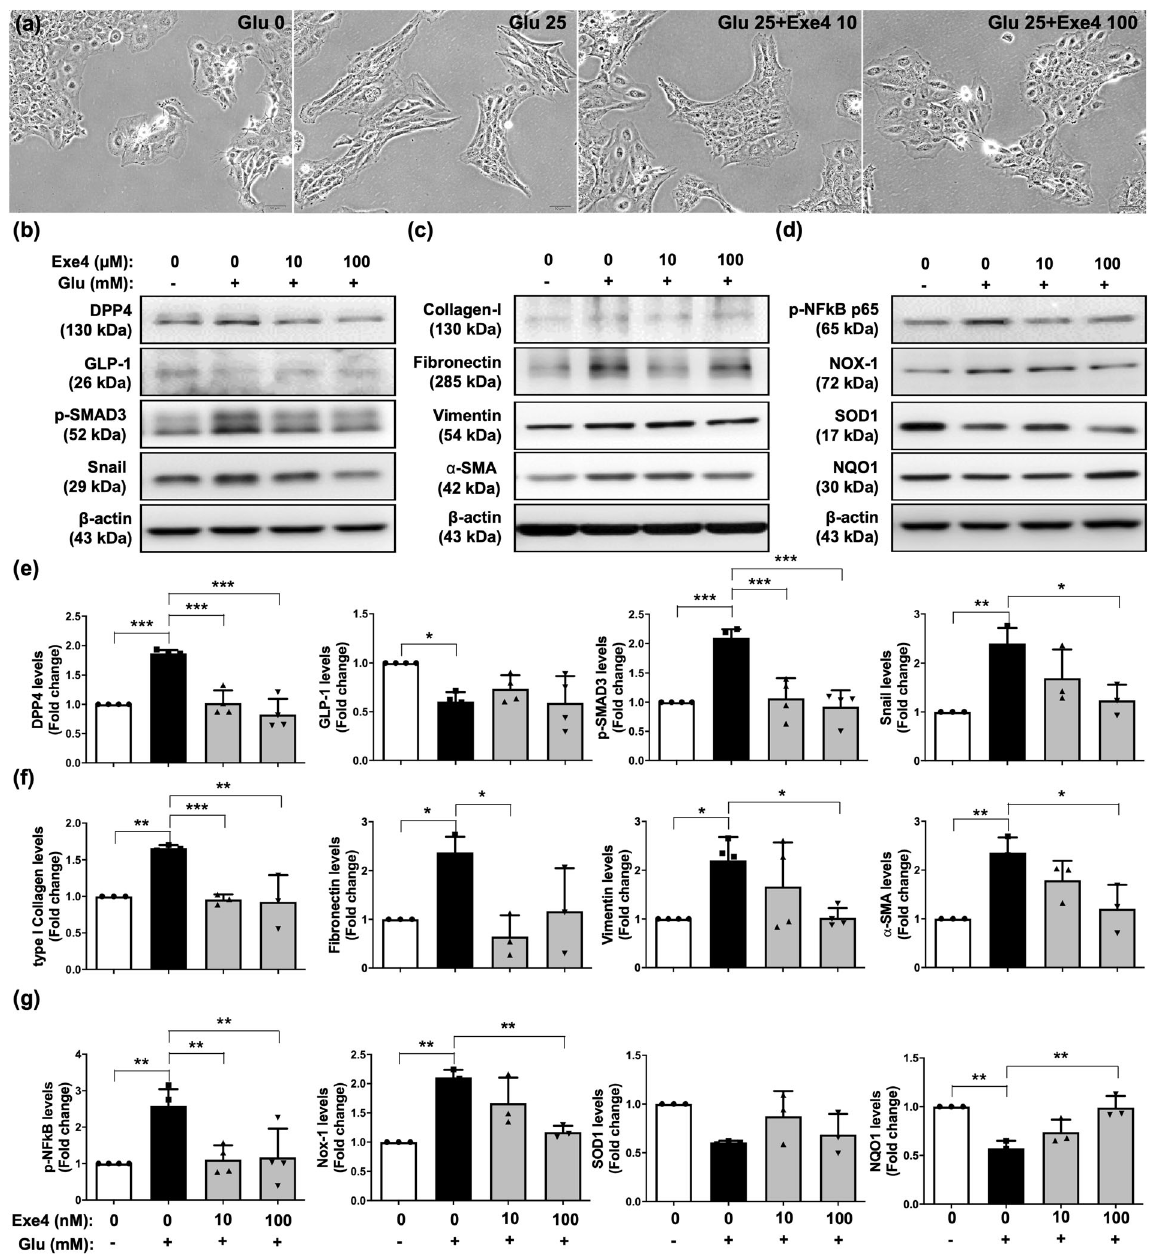
Fig. 3 Exendin-4 ameliorated glucose-inducing DPP4 increase, EMT process, in fl ammation, and oxidative stress in mesothelial cells. a Met-5A cells were induced with or without 25 mM D-glucose (Glu) exposure for 120 h. Under 25 mM D-glucose (Glu) induction, Met-5A cells were treated exendin-4 (Exe4) with 0, 10, or 100 nM concentrations, and then observed cell morphology by microcopy at 200×. Scale bars: 50 μ m. b Western blotting was performed to detect the protein levels of DPP4, GLP-1, p-SMAD3, and Snail. c Western blotting was performed to evaluate the protein levels of collagen-I (type I collagen), fi bronectin, vimentin, and α -SMA. d Western blotting was performed to analyze the protein levels of p-NF-kB, NOX-1, SOD1, and NQO1. e – g Quantitative results of Fig. 3b, c, and d were shown, respectively. The relative levels were normalized and compared by 0 mM glucose concentration. Data represents the analysis of at least 3 independent experiments and shows mean ± SD. * indicates p -value <0.05; ** represents p -value <0.01; and *** is p -value